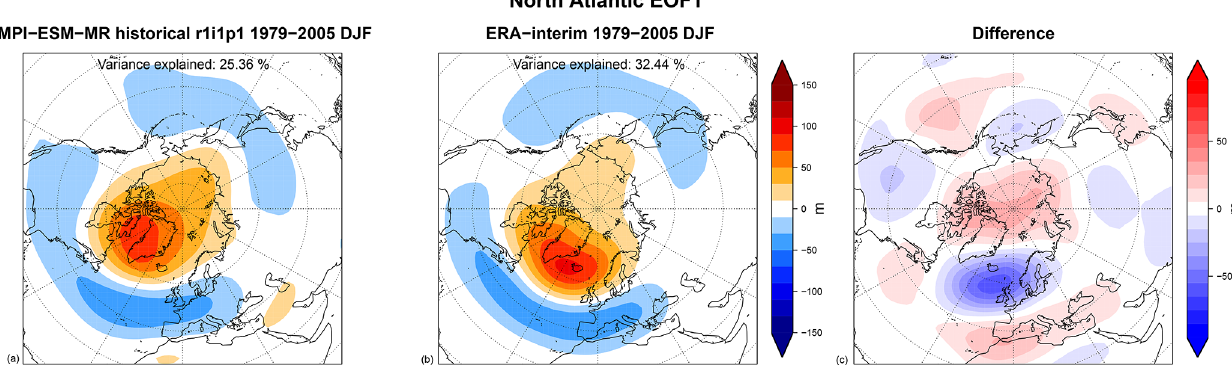
Figure 19. Linear regression over the 500 hPa geopotential height (m) of the first North Atlantic EOF (i.e. the North Atlantic Oscillation, NAO) over the 1979–2005 DJF period for (a) the CMIP5 MPI-ESM-MR historical r1i1p1 run, (b) the ERA-Interim Reanalysis, and (c) their differences. The variance explained is reported at the top of each panel. Produced with recipe_miles_eof.yml ; see details in Sect.